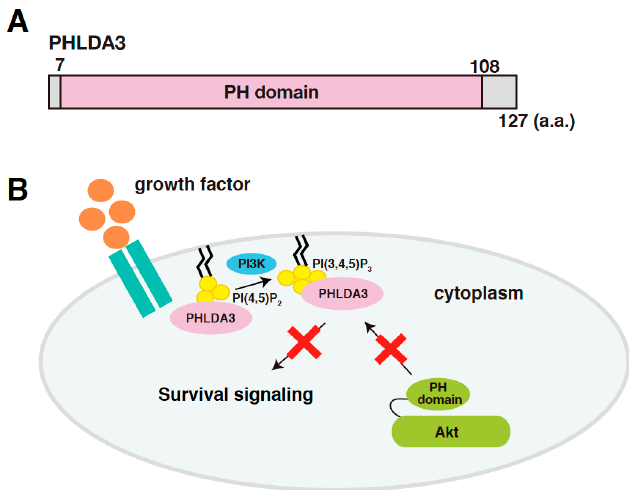
Figure 1. PHLDA3 is a target gene of p53 and encodes a protein that functions as an endogenous inhibitor of Akt. ( A ) A schematic diagram of PHLDA3. Pleckstrin Homology (PH) domain is the only known protein domain in PHLDA3. ( B ) A model of Akt repression by PHLDA3. PHLDA3 functions as a dominant negative repressor of Akt. PHLDA3 localizes to the plasma membrane via binding to phosphatidylinositol phosphates (PIPs), thereby competing with Akt binding to PIPs and suppressing Akt ‐ mediated survival signaling.